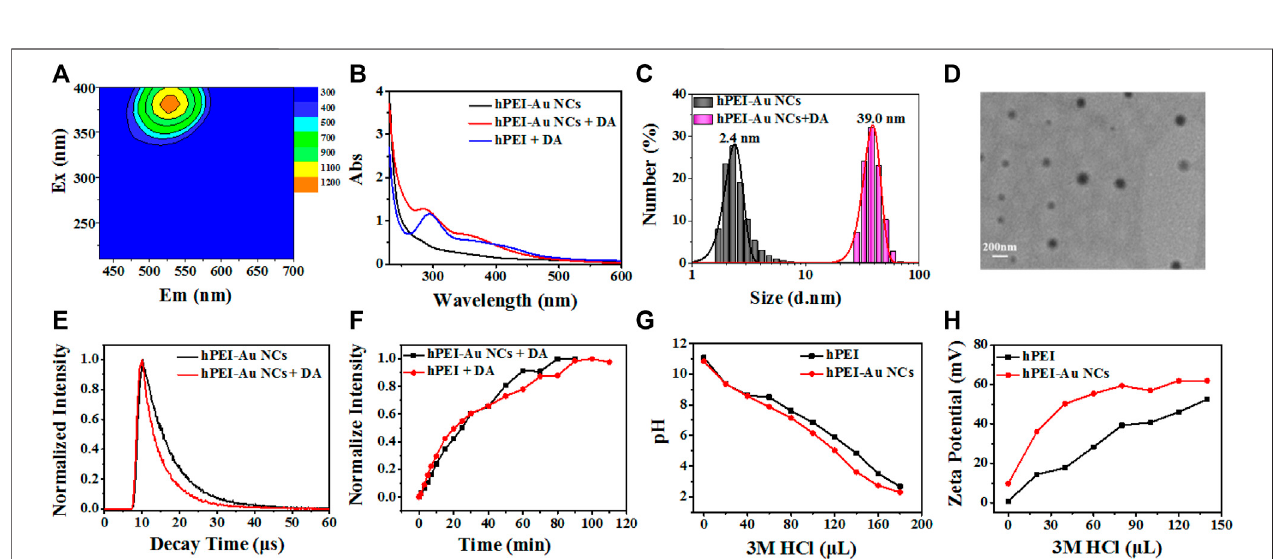
FIGURE 3 | (A) 3D fl uorescence emission spectra of hPEI solution after adding DA. (B) UV – vis absorption spectra of hPEI-Au NCs (black line), hPEI-Au NCs-DA mixture (red line), and hPEI-DA mixture (blue line). (C) Hydrodynamic diameter of hPEI-Au NCs without (gray histogram) and with (purple histogram) the addition of DA. (D) TEM image of hPEI-Au NCs-DA mixture. (E) Time-resolved fl uorescence emission spectra of hPEI-Au NCs in the absence (black line) and presence (red line) of DA. (F) Time-dependent fl uorescence variation of I 520 of hPEI-Au NCs-DA mixture (black line) and hPEI-DA mixture (red line). (G) pH variation of hPEI (black line) and hPEI-Au NCs (red line) upon adding HCl. (H) Surface charge variation of hPEI (black line) and hPEI-Au NCs (red line) upon adding HCl.